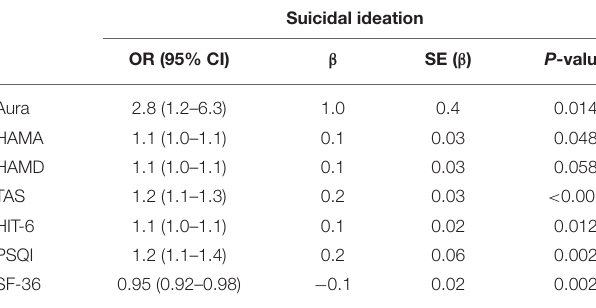
TABLE 4 | Multivariable logistic regression analysis of factors associated with suicidal ideation in students with